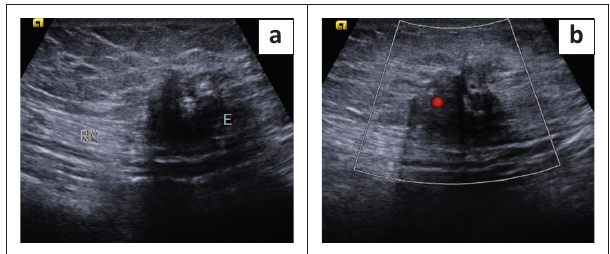
FIGURE 1: Scar endometriosis in a 36-year-old lady with previous history of sling surgery with current complains of painful swelling at the incisional site. Grey scale ultrasound image in the region of swelling (a) demonstrates an ill-defined hypoechoic area (labelled E, rectus muscle [RM]) with two internal echogenic foci and extensive posterior shadowing in the subcutaneous plane. Minimal vascularity was seen on power Doppler (b).